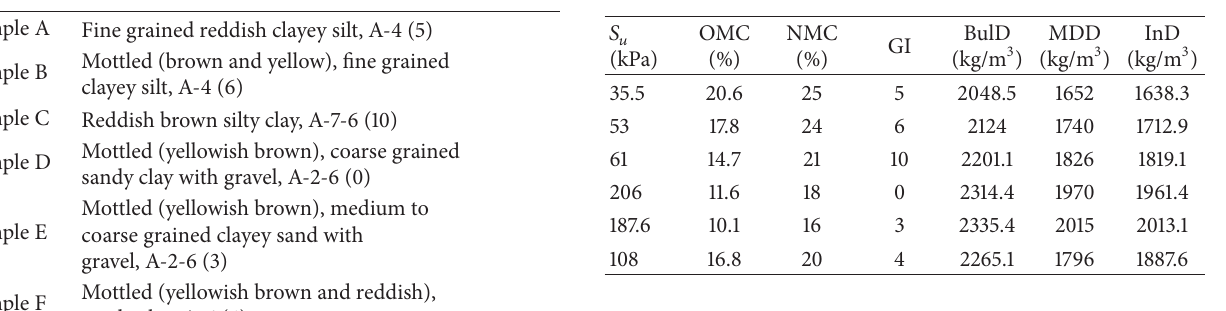
Table 2: Summary of soil identification and classification for the lateritic soils.